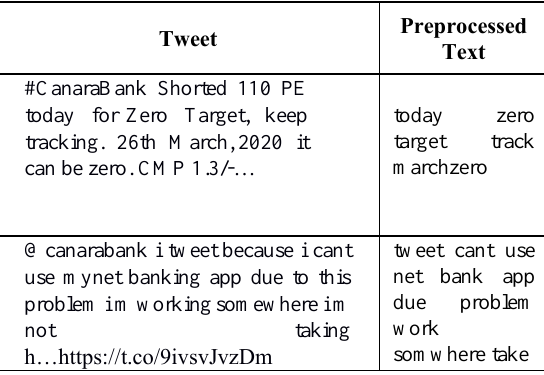
Table 5. Tweets and their pre-processed